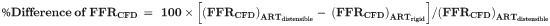
FFRCFD decreases with increasing vessel rigidity.(a) FFRCFD in ARTrigid, ARTpartial and ARTdistensible models (P value was derived from one-way ANOVA analysis), (b) Non-linear regression curve showing relationship between percentage diameter stenosis and percentage difference in FFRCFD between ARTdistensible and ARTrigid models.%Difference of FFRCFD =  100×[(FFRCFD)ARTdistensible− (FFRCFD)ARTrigid]/(FFRCFD)ARTdistensible